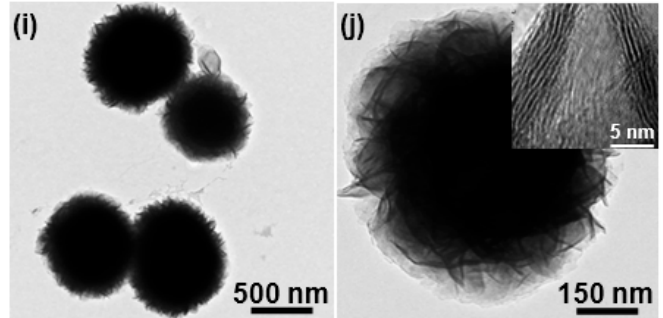
Figure 3. ( a , b ) FE-SEM images of SiO 2 /RGO/MoS 2 microspheres at low and high magnifications, respectively; ( c , d ) FE-SEM as well as ( e , f ) TEM images of MoS 2 /RGO hollow microspheres at different magnifications; the inset in ( f ) is an HRTEM image of a random MoS 2 nanosheet anchored on a MoS 2 /RGO hollow microsphere, showing its (002) lattice plane; ( g , h ) FE-SEM as well as ( i , j ) TEM images of bare MoS 2 microspheres at different magnifications; the inset in ( j ) is an HRTEM image of an arbitrary MoS 2 nanosheet located on a bare MoS 2 microsphere, showing the (002) lattice plane as well.